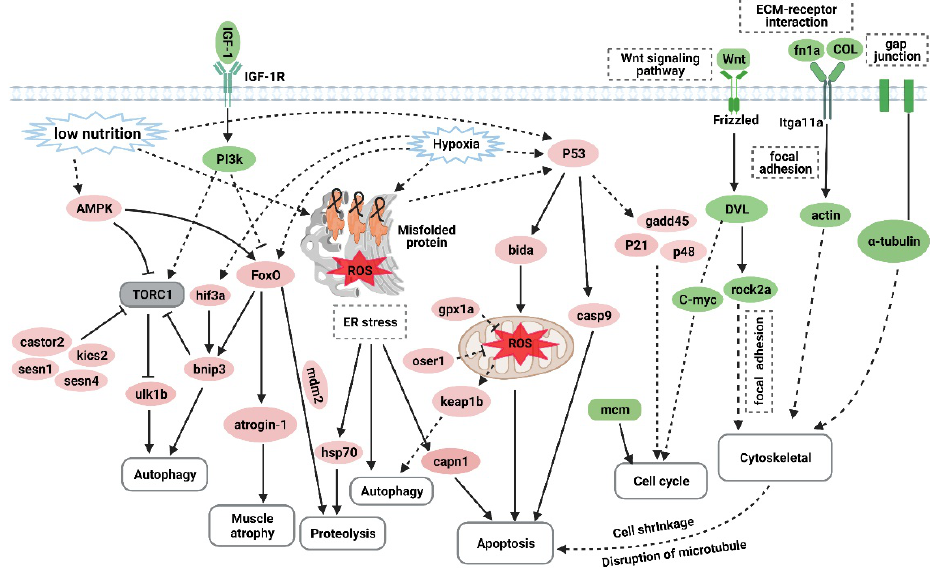
Figure 7. The hypothetical pathogenesis mechanism of muscle atrophy induced by excessive exercise in zebrafish. The upregulated genes are shown in red ovals, and the downregulated genes are shown in green ovals. In response to excessive exercise, the muscle cells may undergo the following events: (1) the inhibition of IGF–PI3K signaling and upregulation of AMPK inhibit the function of the TORC1 complex to suppress protein synthesis and promote autophagy; (2) excessive exercise activates FoxO signaling, which promotes the expression of protein hydrolysis, autophagy, and muscle ‐ atrophy ‐ related gene expression; (3) excessive exercise induces oxidative stress, and the accumulation of misfolded proteins in the endoplasmic reticulum and the activation of p53 sig ‐ naling lead to proteolysis, autophagy, and apoptosis; (4) overtraining inhibits Wnt signaling and the expression of the MCM complex, which suppresses the proliferation of muscle satellites; and (5) excessive exercise destroys ECM–receptor interaction, focal adhesion, and the gap junction of muscle cells, leading to cytoskeleton damage and inducing apoptosis. (Created with BioRen ‐ der.com.)